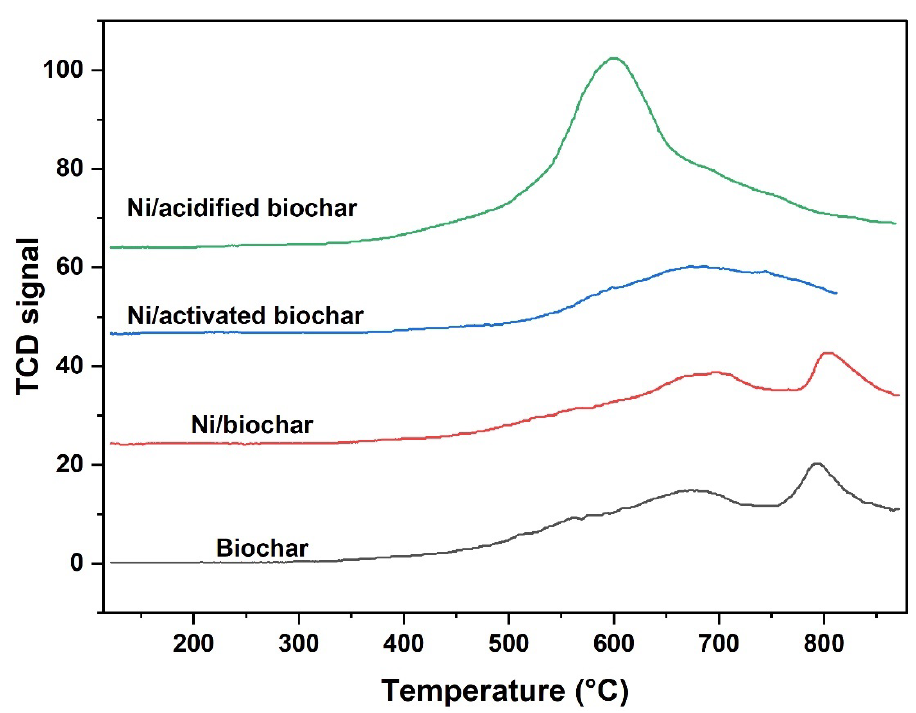
Figure 7. CO 2 -TPD profile of raw biochar, Ni/biochar, Ni/biochar (KOH), and Ni/biochar (H 2 SO 4 ) catalysts.